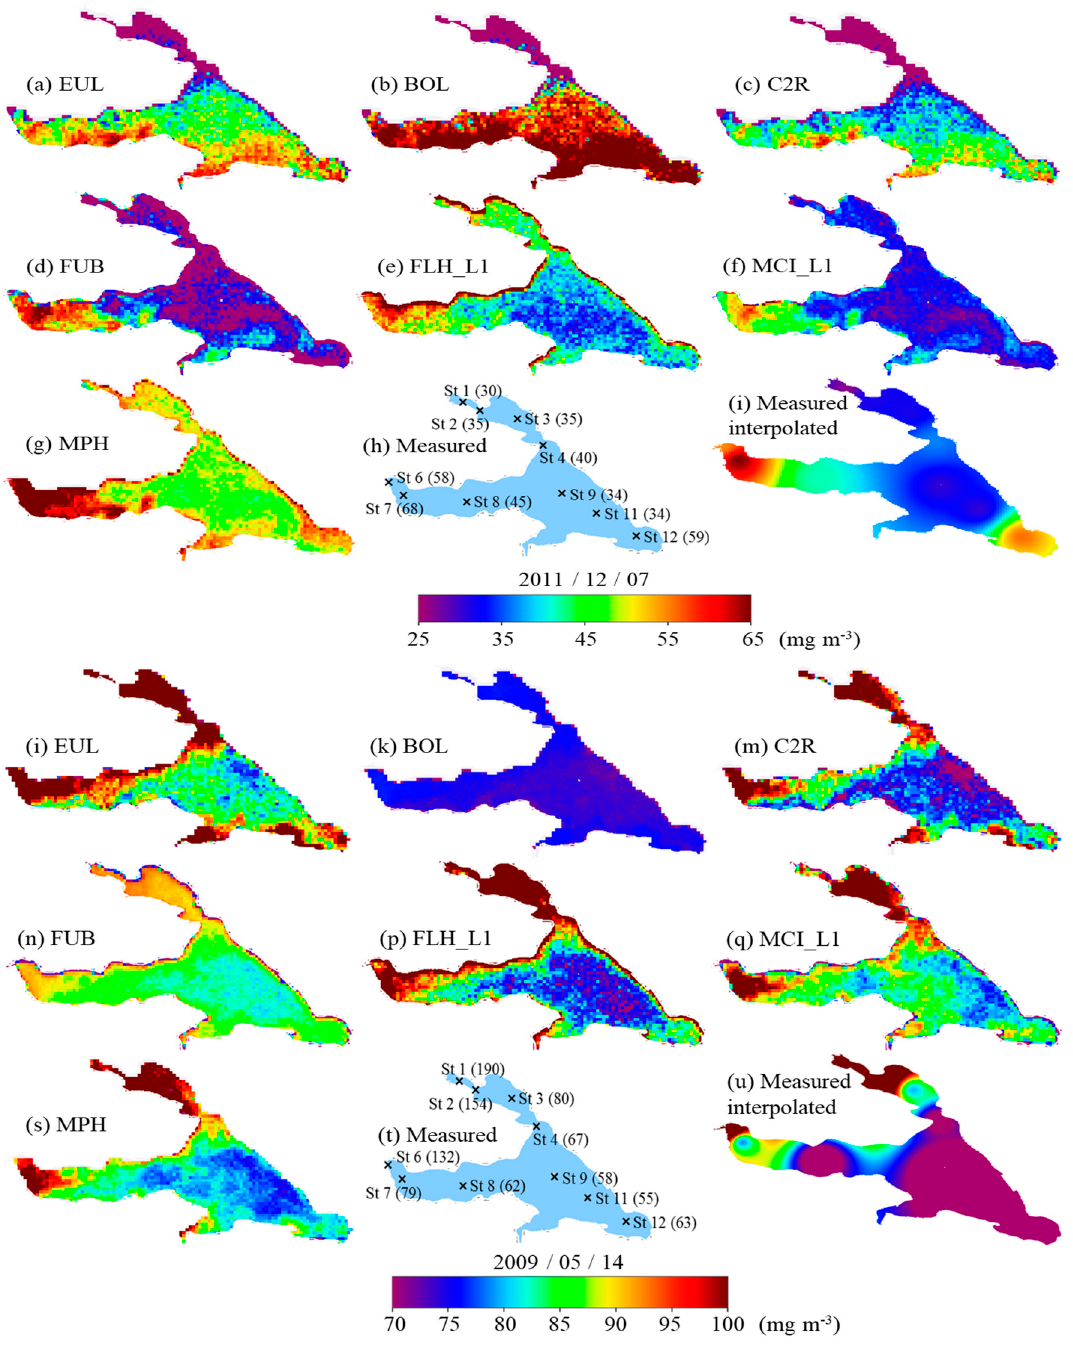
Figure 8. Spatial distribution of chlorophyll-a (Chla) concentration in Lake Kasumigaura on 7 December 2011 (low Chla concentrations) and 14 May 2009 (high Chla concentrations) using ( a , i ) EUL; ( b , k ) BOL; ( c , m ) C2R; ( d , n ) FUB; ( e , p ) FLH; ( f , q ) MCI; and ( g , s ) MPH processors. The measured Chla at the ten stations of the National Institute for Environmental Studies (NIES) shown in ( h , t ), and ( I , u ) illustrate the interpolated measured Chla. The units of measured and retrieved Chla are in mg ∙ m − 3 .